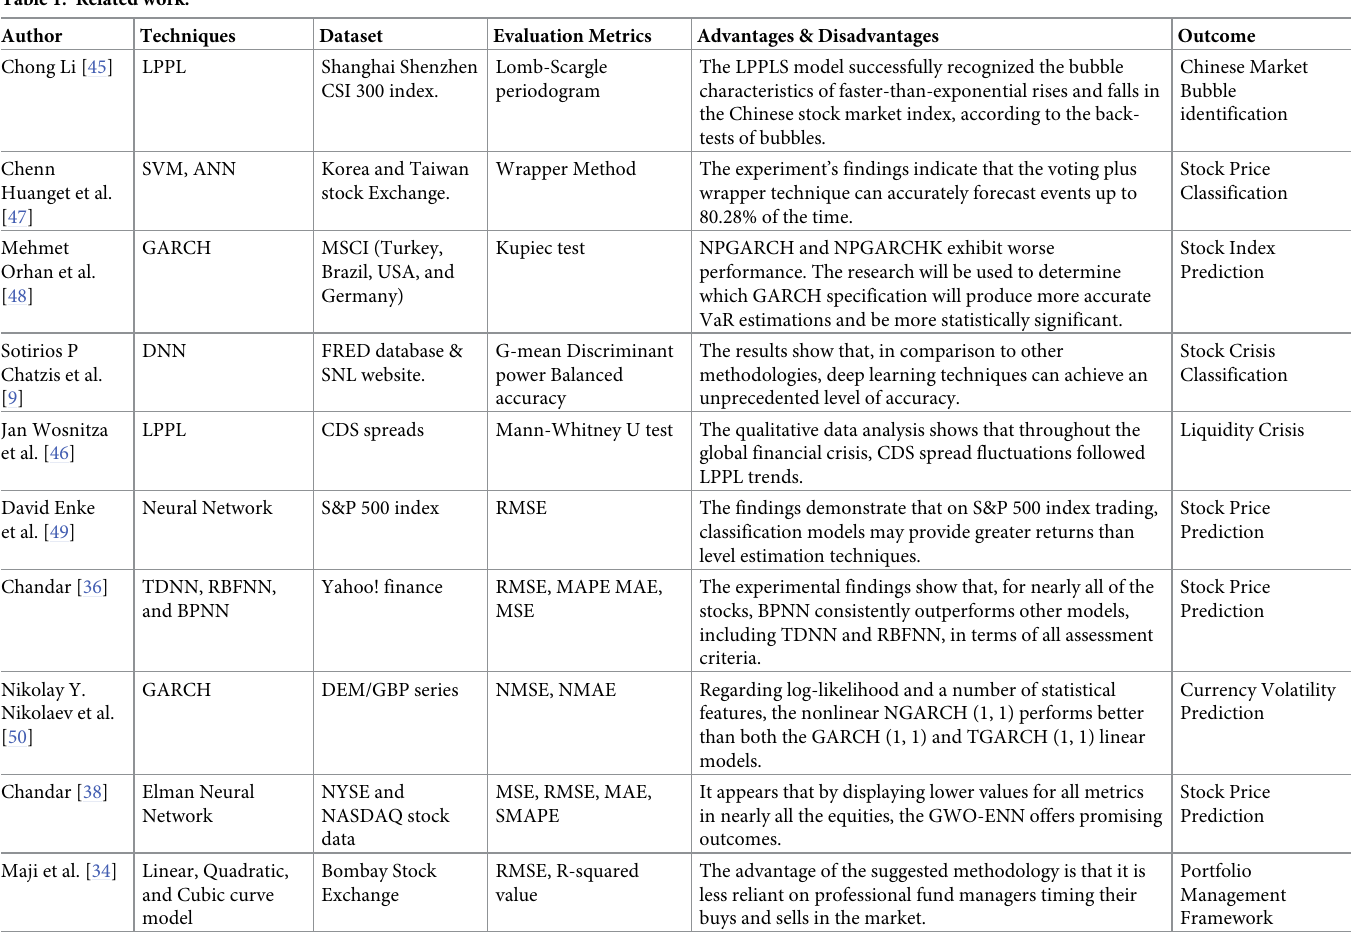
Algorithm #1. Hybridized Feature Selection